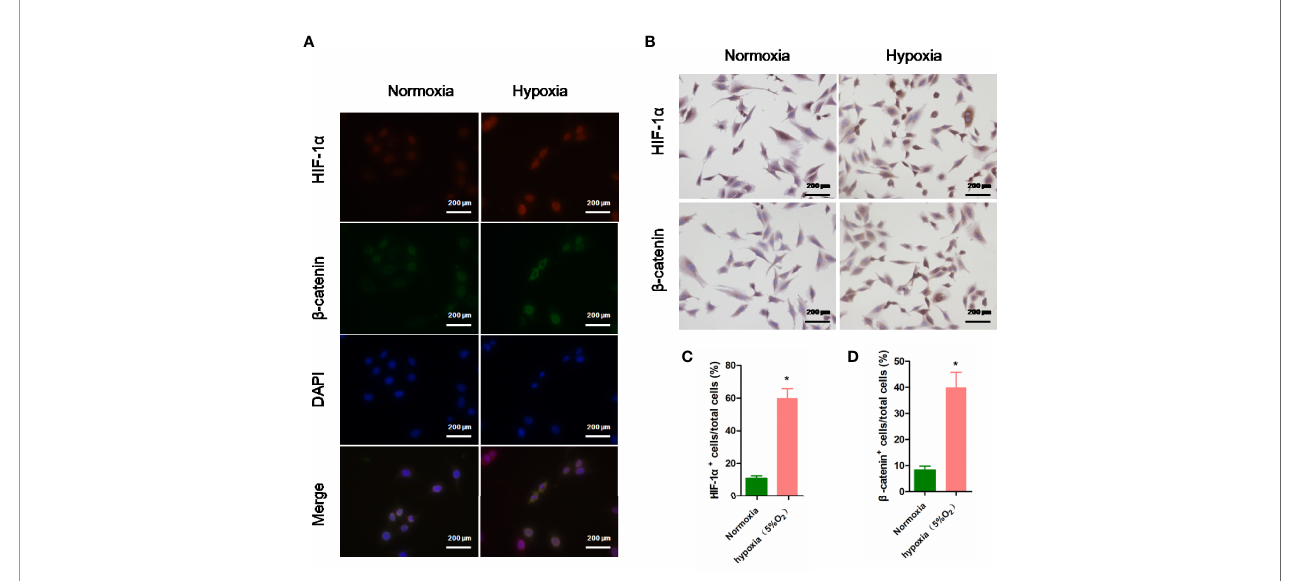
FIGURE 4 | Immunoassay of HIF-1 a and b -catenin in rPBMSCs under normoxia and hypoxia (5% O 2 ). (A) Nuclear expression of HIF-1 a (red) and b -catenin (green) in rPBMSCs treated under normoxia and hypoxia (5% O 2 ) for 5 days. (B) Nuclear expression of HIF-1 a (brown) and b -catenin (brown) in rPBMSCs treated under normoxia and hypoxia (5% O 2 ) for 5 days. (C, D) Quantitative analysis of HIF-1 a (brown) and b -catenin (brown) in rPBMSCs in panel (B) . Magni fi cation, 200×. All data are presented as means ± SEM. P < 0. 05; ∗ vs control group. rPBMSCs, rat peripheral blood-derived mesenchymal stromal cells; HIF-1 a , hypoxia-inducible factor 1 a .